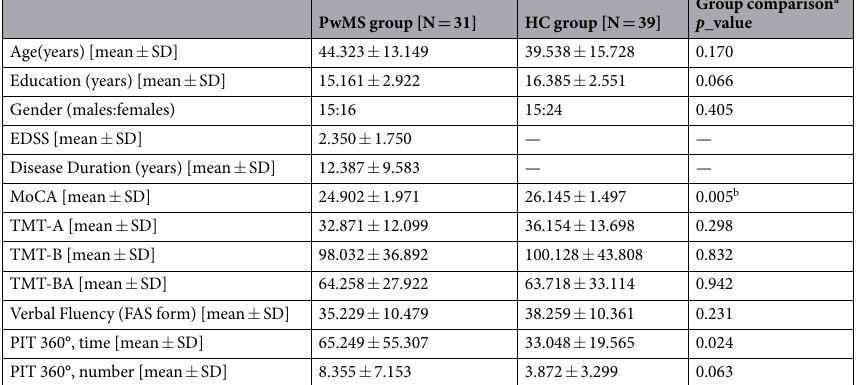
Table 1. Sociodemographics, neuropsychological assessment and PIT 360° scores for PwMS and HC groups. Abbreviations: PwMS, People with Multiple Sclerosis; HC, Healthy Control; EDSS, Expanded Disability Status Scale; MoCA, Montreal Cognitive Assessment; TMT, Trail Making Test; FAS, administration letters to test Verbal Fluency; PIT, Picture Interpretation Test. a Sociodemographic and neuropsychological variables were compared at baseline using t test or χ 2 as appropriate. b Because the Levene’s test was significant, the t-test reported assumes that variances were not equal and df =